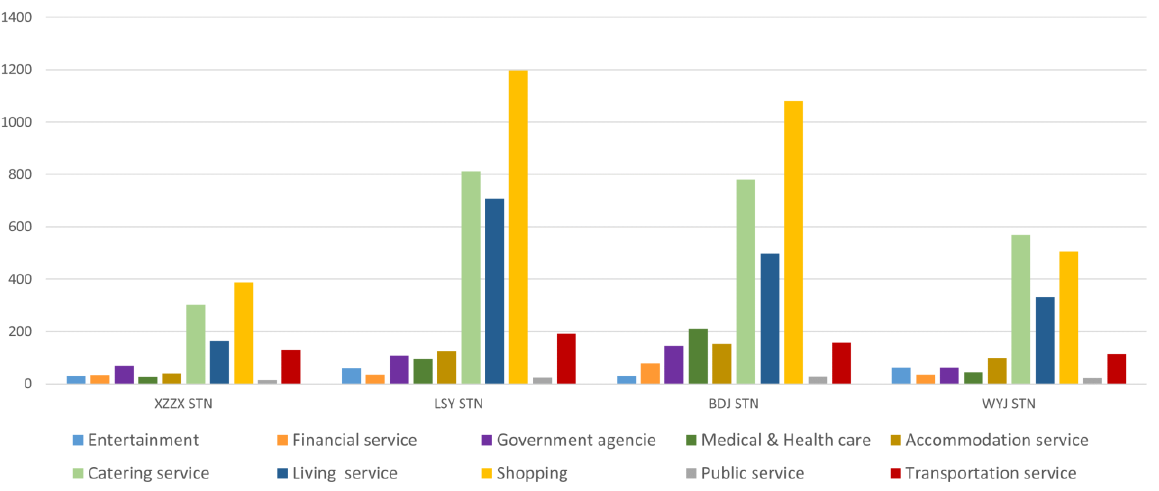
Figure 8. Statistics on the number of POIs for each research station realm.